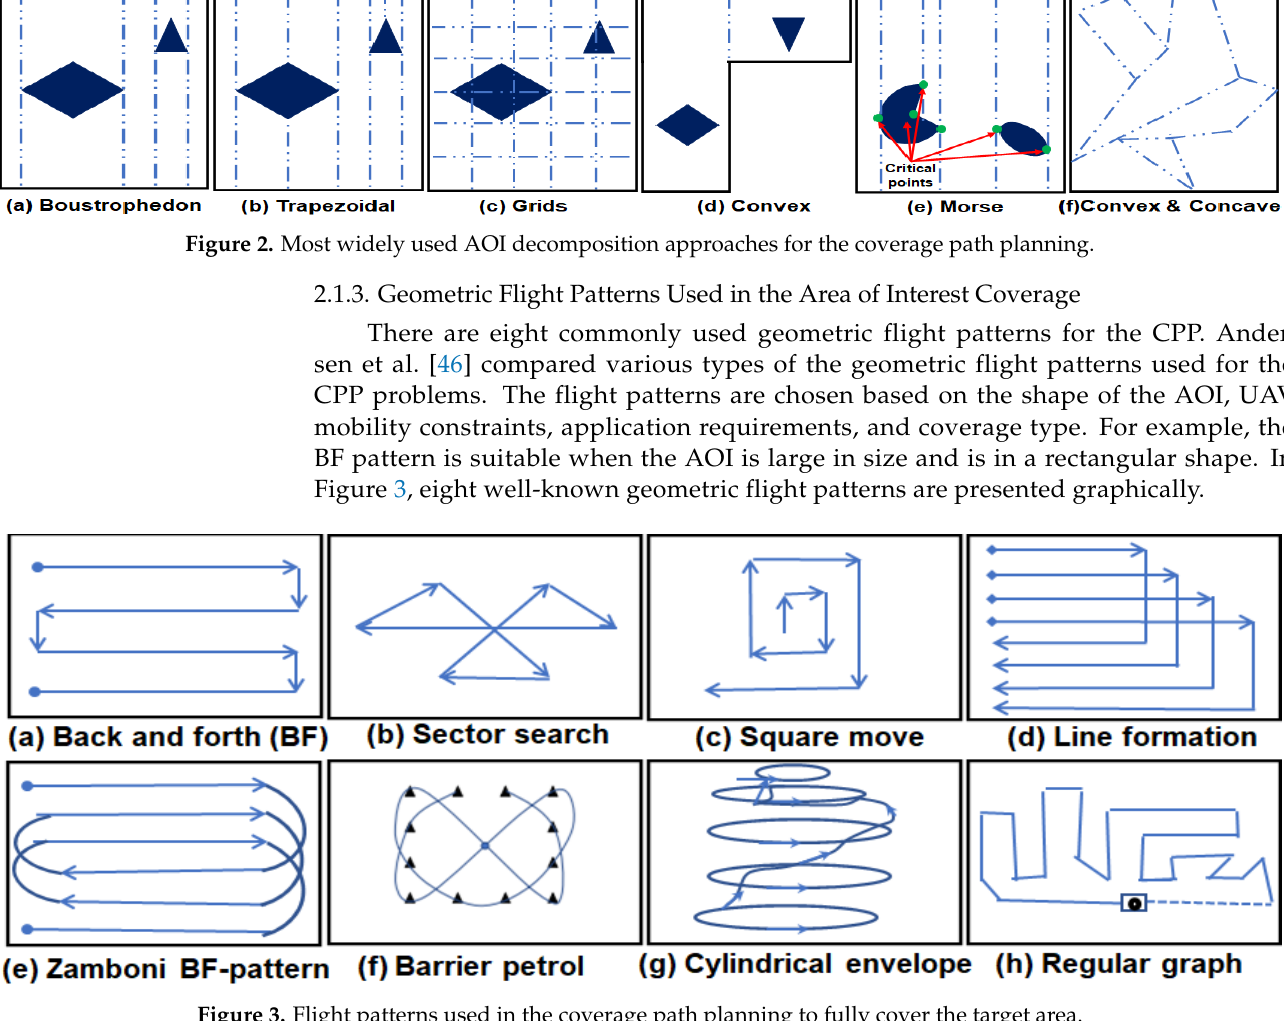
Figure 3. Flight patterns used in the coverage path planning to fully cover the target